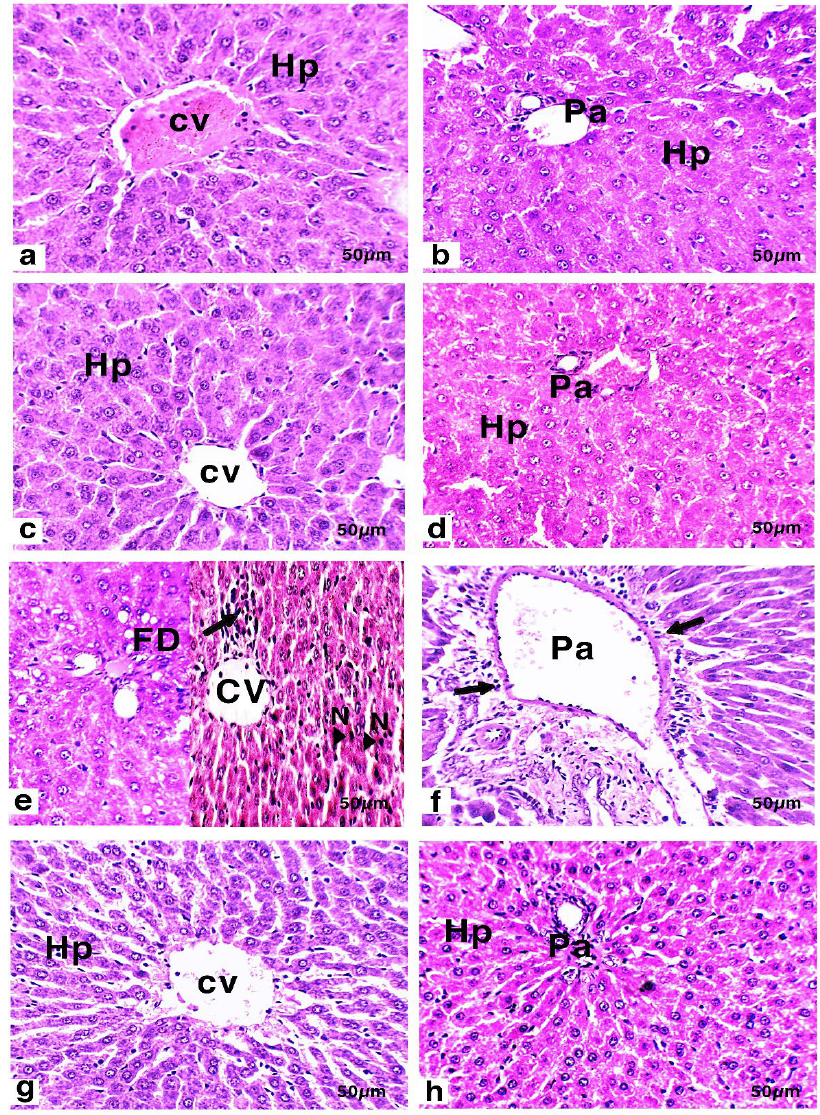
Figure 2. ( a , b ) Liver section of a control rat. ( c , d ) Liver sections of rats treated with methanolic extract of date flesh (DF) showed a normal histological structure of hepatocytes (Hp) surrounding the central vein (CV) and the portal area (Pa). ( e , f ) Liver sections of rats treated with cisplatin (Cis) showed mild fatty degeneration (FD), focal necrosis (N) near the central liver region, and infiltration of the inflammatory area (arrow) surrounding the portal area (Pa) and (CV). ( g , h ) Liver sections of the group pretreated with methanolic extract of date flesh before injection with cisplatin (DF/Cis) exhibited normal histological structure of hepatocytes (Hp) surrounding the central vein (CV) and the portal area (Pa). Scale bar = 50 µ m (H&E,